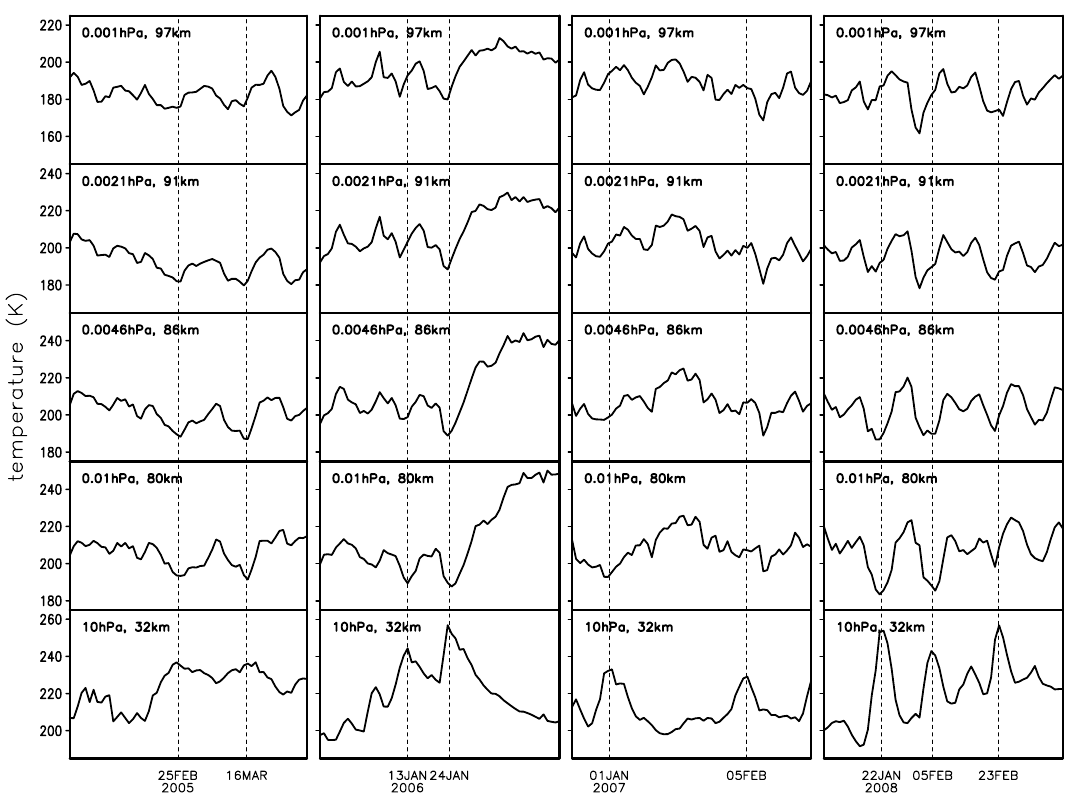
Fig. 9. Time sequences of the 80–85 ◦ N zonal mean temperature at 10, 0.01, 0.0046, 0.0021 and 0.001hPa during the 4 winters (2004/2005– 2007/2008).